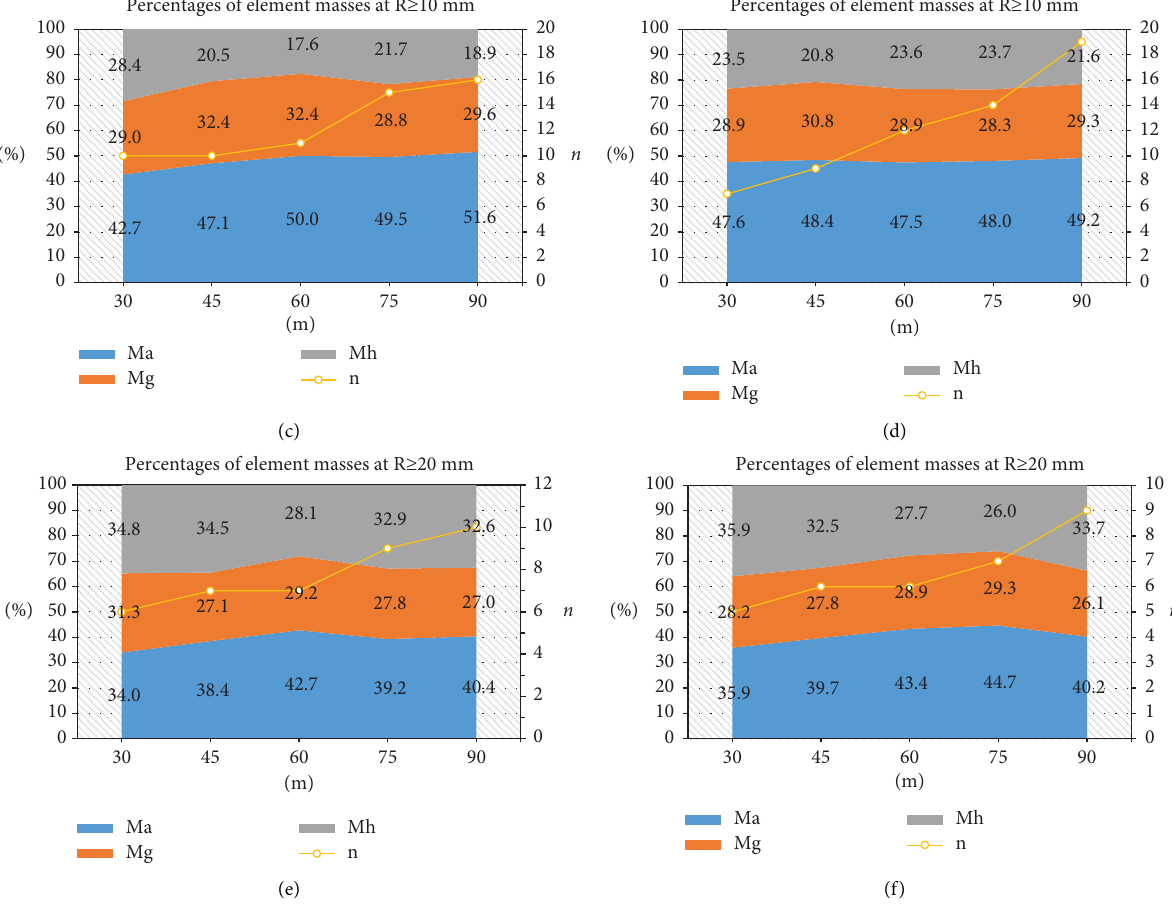
M g , M h and the number of sections n : (a), (c), (e)—at variable angles a ,